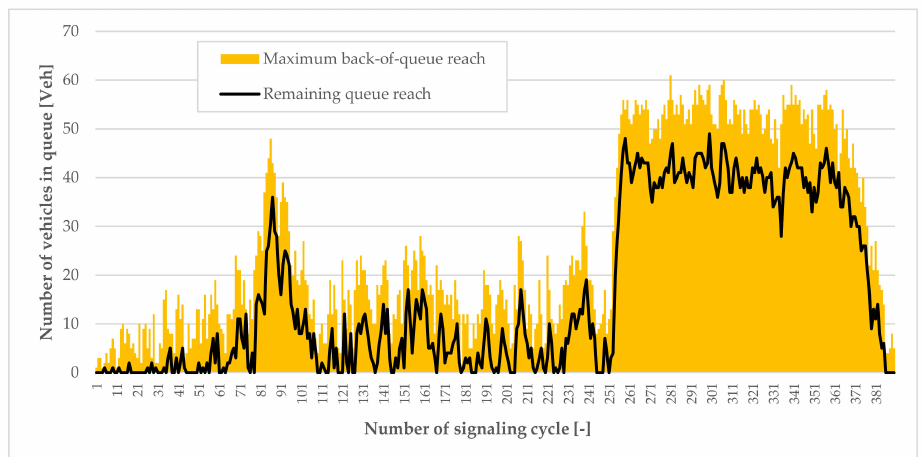
Figure 7. Distribution of the number of vehicles in the maximum back-of-queue for a given lane at the approach in individual signaling cycles in a given measurement period (including vehicles Figure 8. Starting-up times for the vehicles forming the maximum back-of-queues for a given lane controlled by traffic signal heads with the same signal control parameters, i.e., green signal and cycle